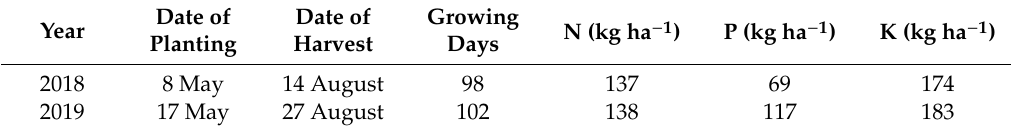
Table 1. Date of planting and harvest and the fertilization in the two experimental